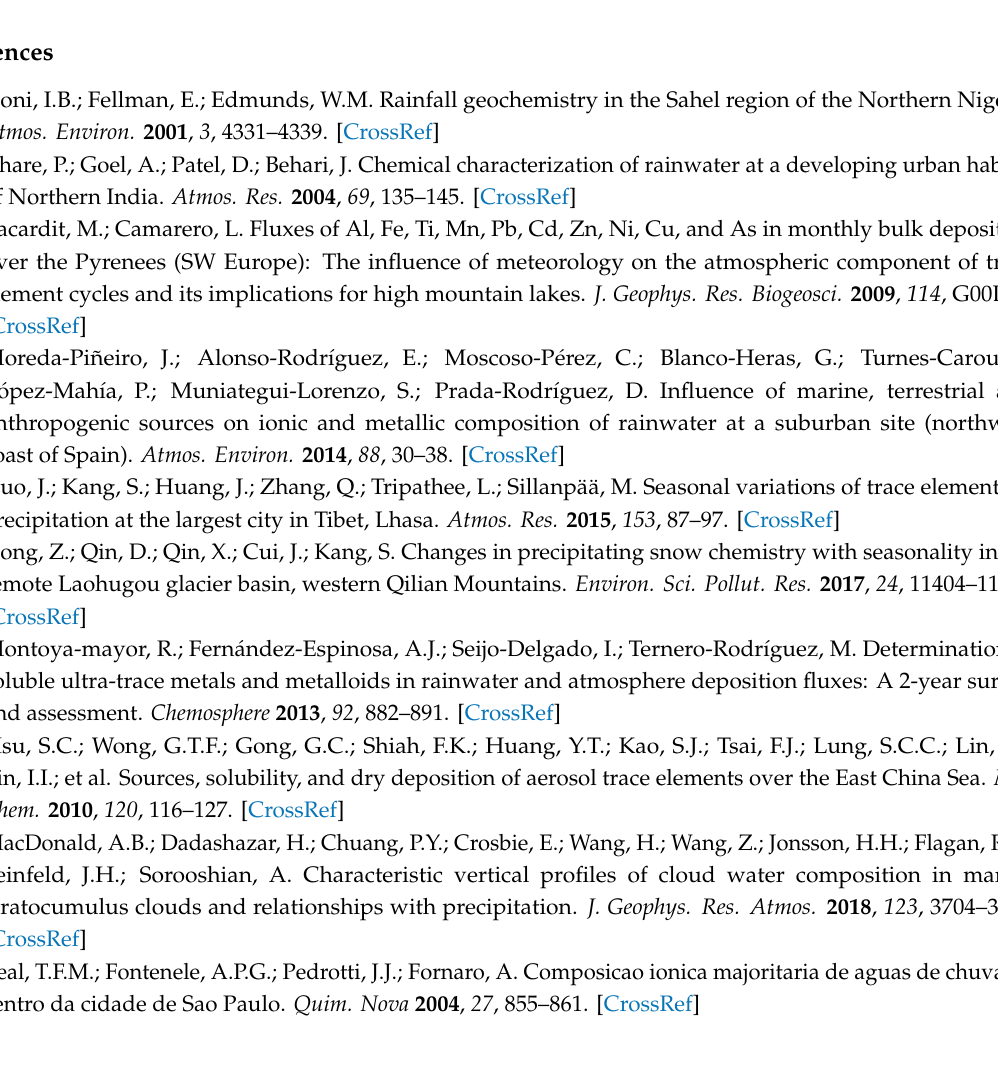
Table S1: Monthly climate data for the studied locations of Central